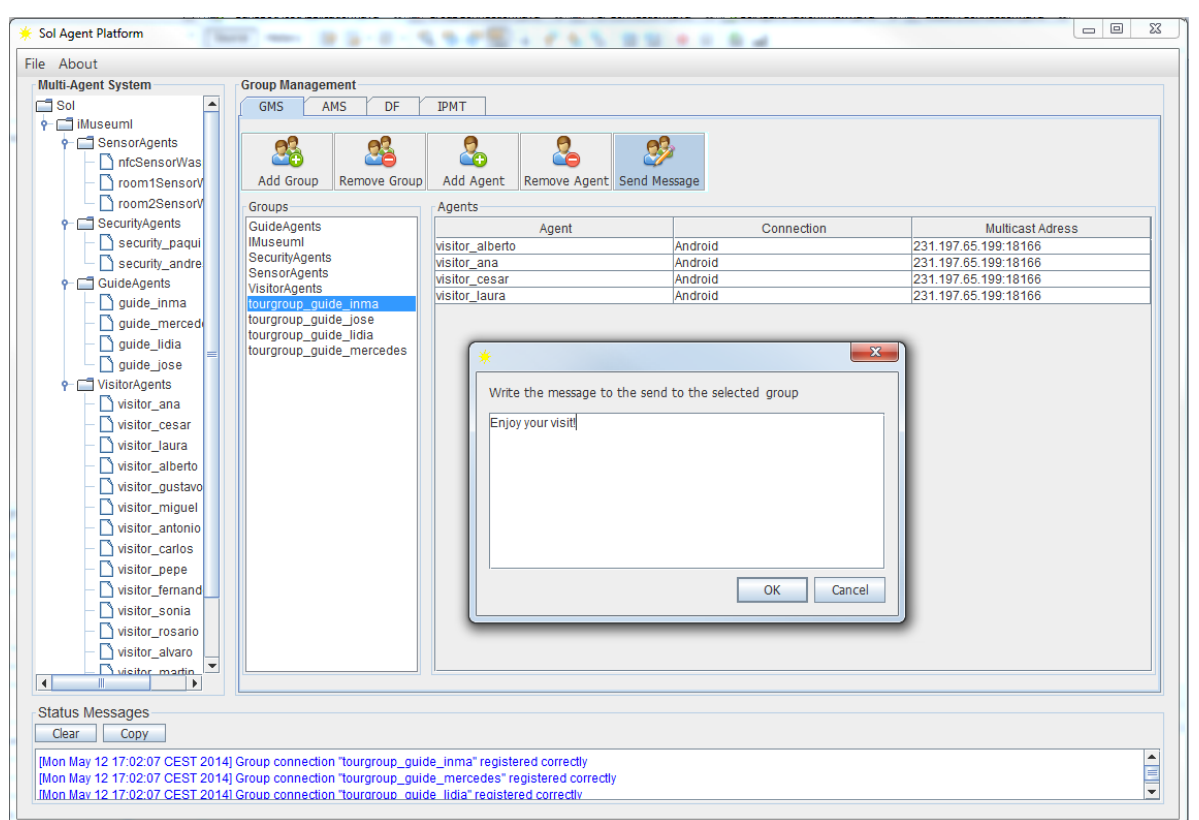
Figure 10. The Sol agent platform user interface for group